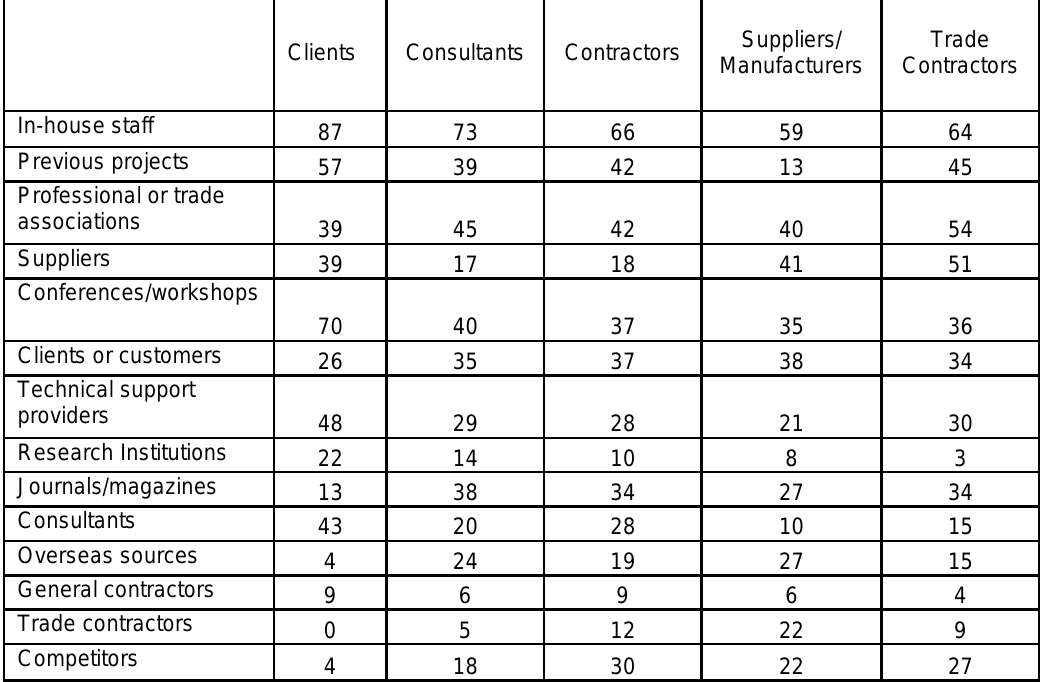
Table 1 : Innovation Sources by Sector